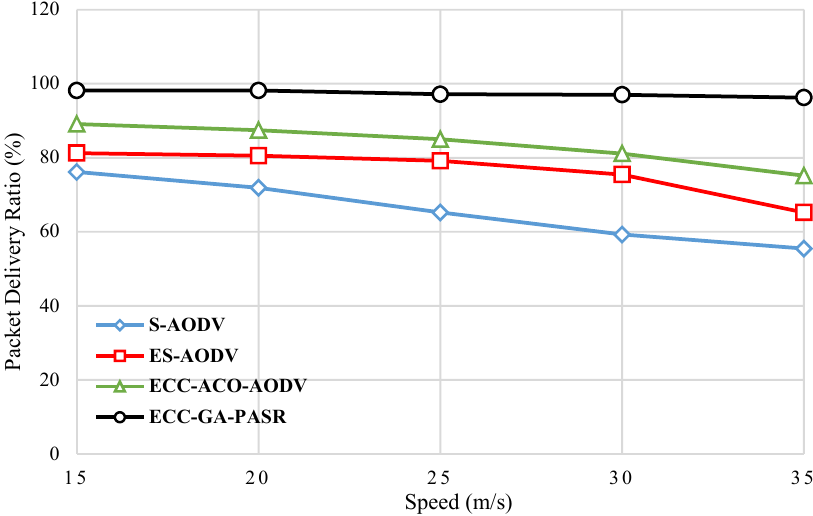
Figure 14. PDR Calculation based on vary speed of vehicle..